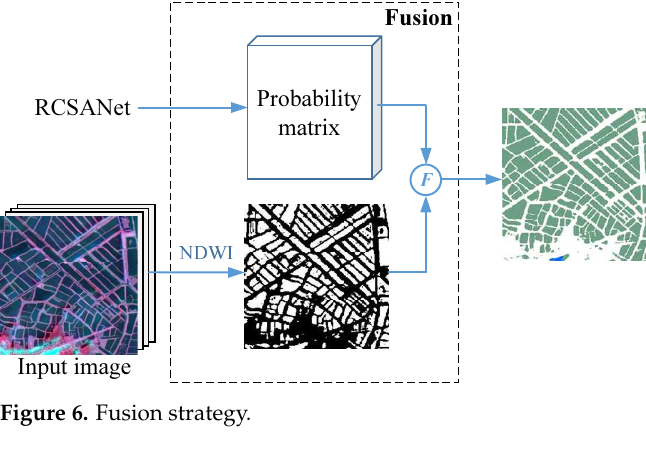
Figure 6. Fusion